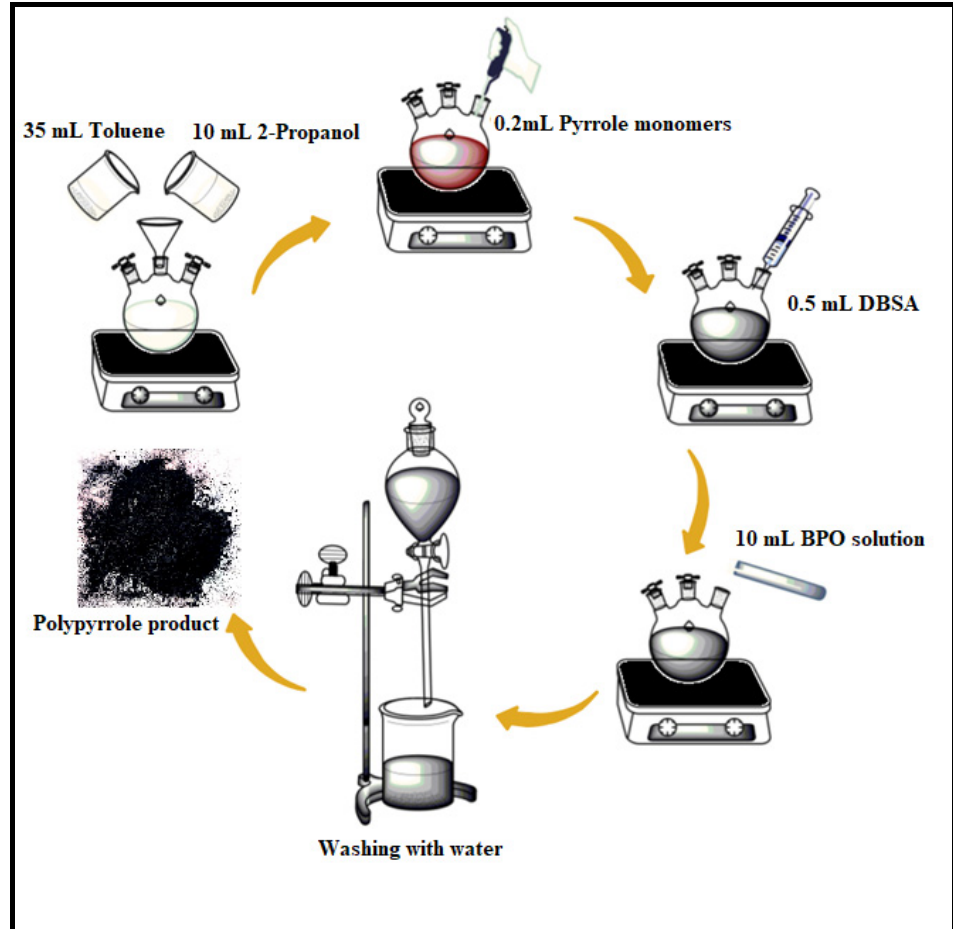
Figure 1. Synthesis route followed for polypyrrole.